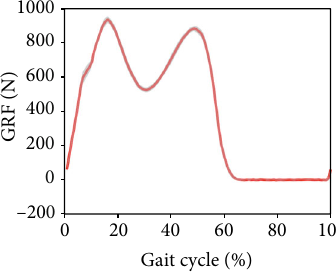
Figure 11: The mean (red) and standard deviation (shaded) of vertical ground reaction force during preferred-speed walking. These results are from subject AB04 (Trial 3) and include 29 gait